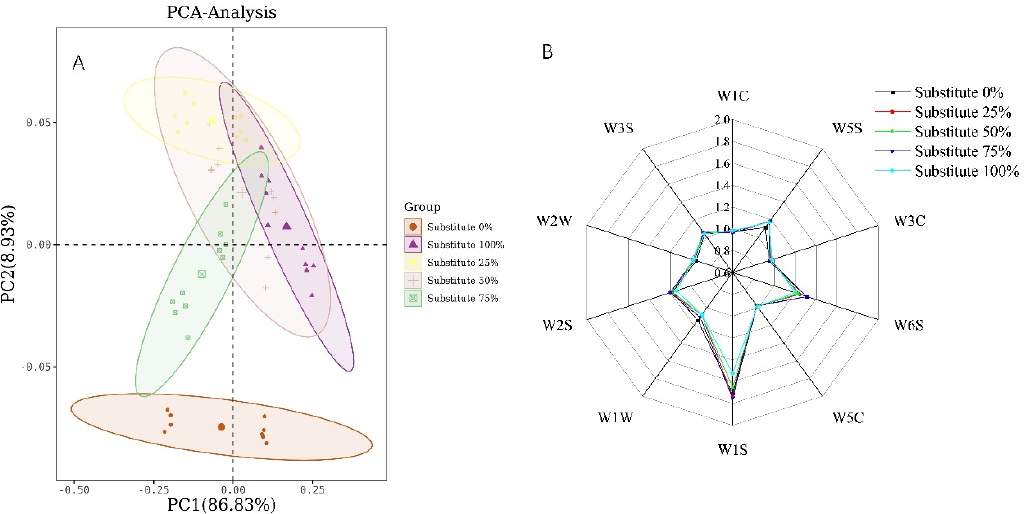
Figure 4. Effect of replacing milk fat with SOBs on the flavor of the yogurt: ( A ) PCA analysis of yogurt with different substitution amounts; ( B ) electronic nose radar diagram analysis of yogurt with different substitution amount.